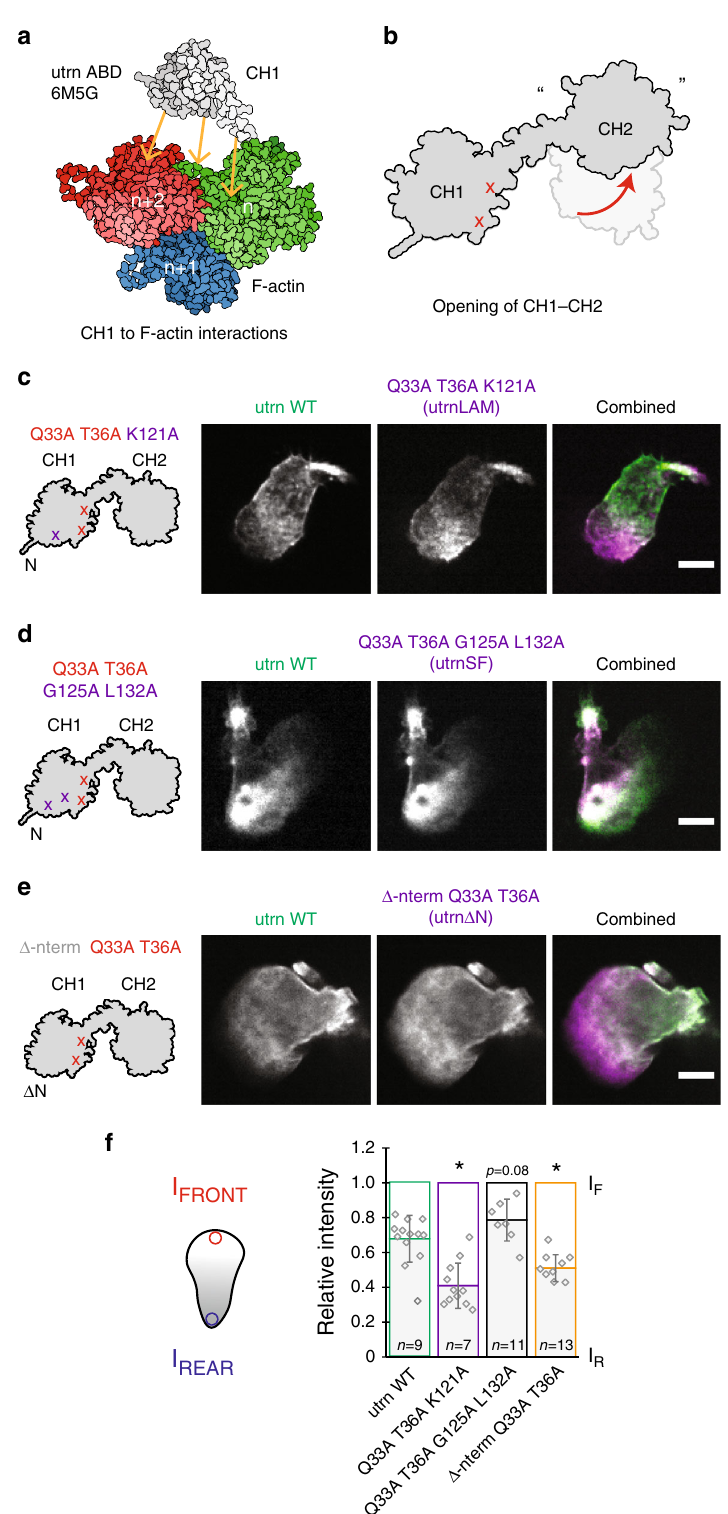
actin-binding domain of α -catenin 49 . For α -catenin, the binding dwell time of single molecules (inverse of the off-rate) was shown to follow a two-timescale binding behaviour, in which the binding dwell times increase as a function of concentration of the domain added. This cooperative change in dwell time was hypothesized to be due to structural changes in F-actin that are induced by α - catenin ’ s actin-binding domain binding to F-actin 49 . In addition,